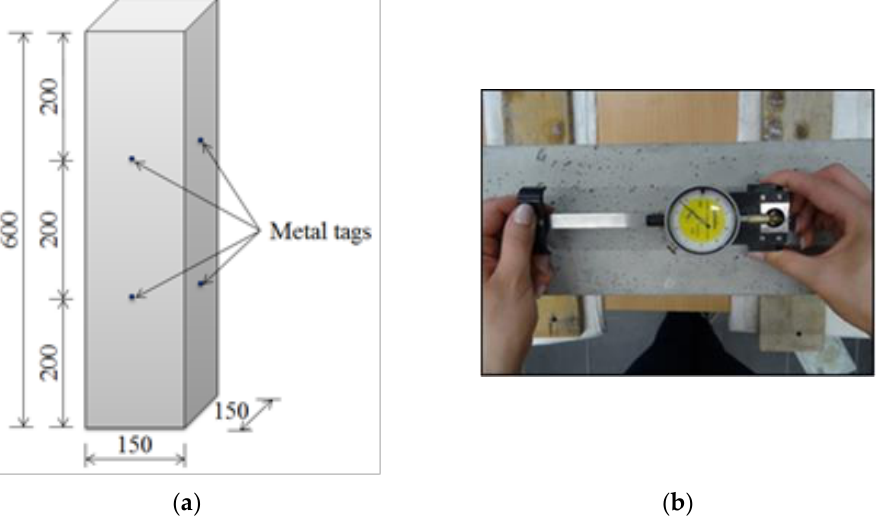
Figure 2. ( a ) Spacing of metal tags for strain measurements, ( b ) measurement of strain with an ex- tensometer.